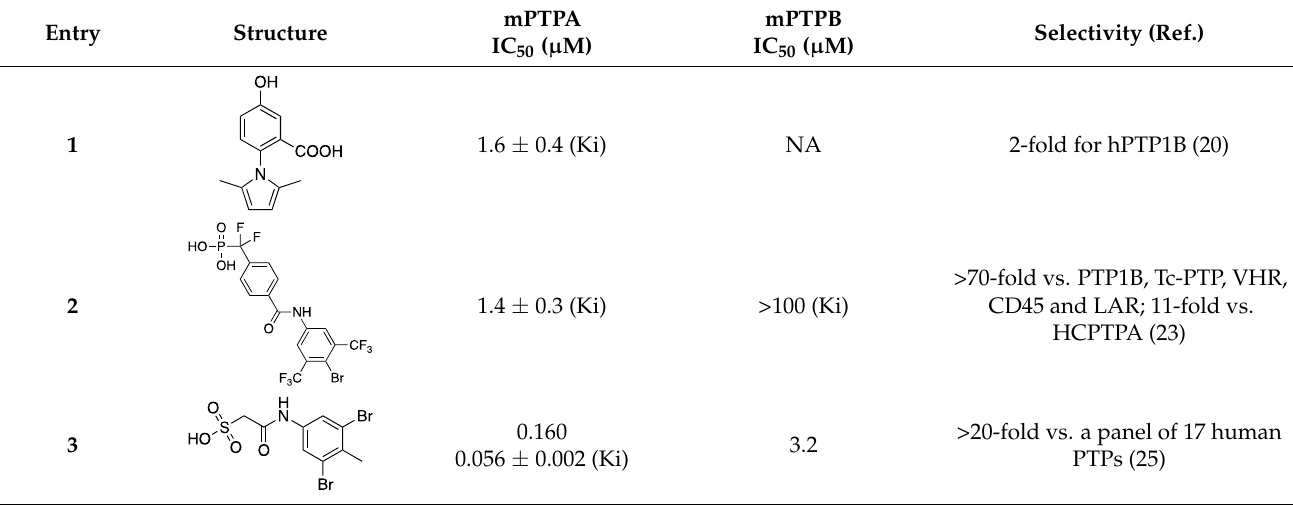
Table 2. Chemical structures and IC 50 values of various mPTPA inhibitors.